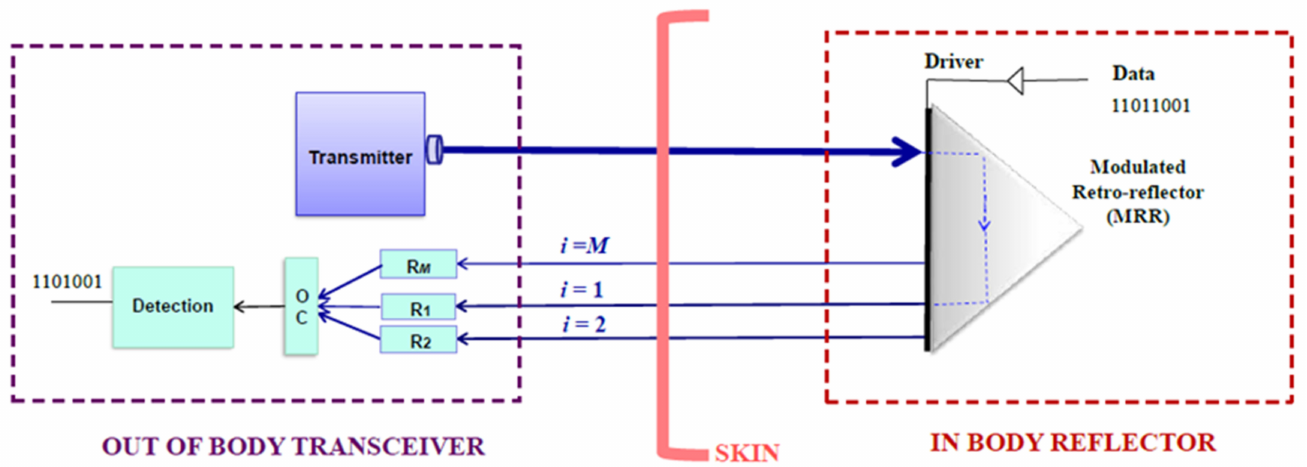
Figure 1. Block diagram of the proposed MRR TOW